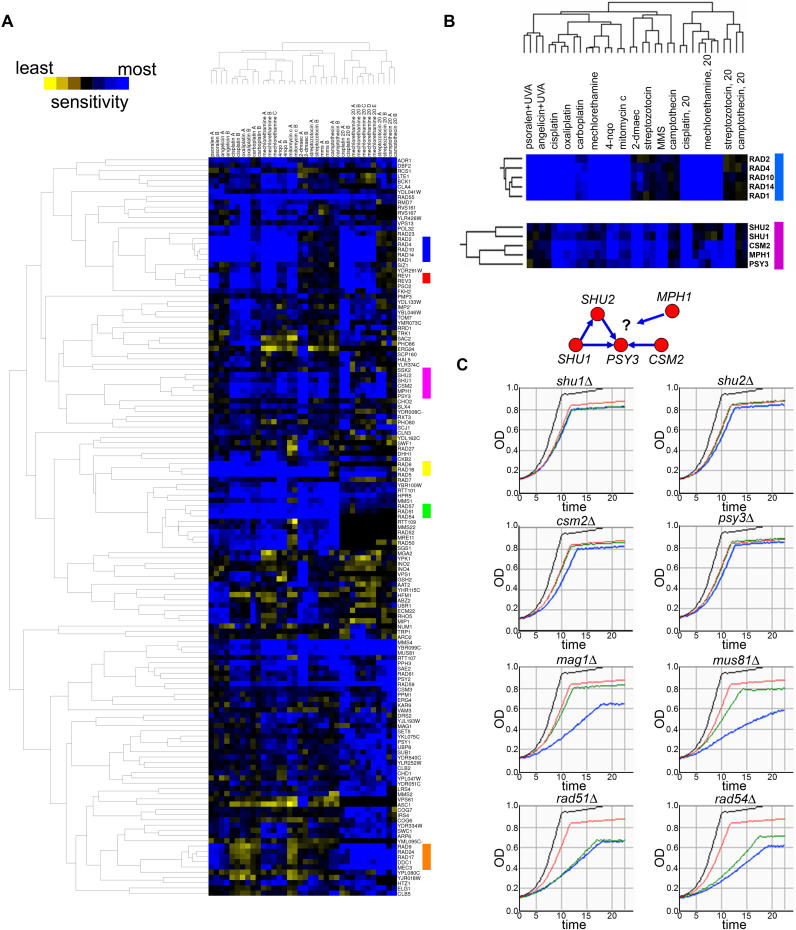
Hierarchical Clustering of Genome-Wide Profiles Identifies Mechanistic Relationships Between Drugs and Functional Relationships Between Genes(A) Clustergram containing all strains significant in two or more array experiments. Raw fitness-defect values were hierarchically clustered using Spearman's rank correlation. Colored bars represent gene clusters of note, including NER (RAD2, RAD4, RAD10, RAD14, and RAD1—blue); error-prone TLS (REV1 and REV3—red); PRR (RAD6, RAD18, and RAD5—yellow); homologous recombination (RAD57, RAD51, and RAD54—green); cell-cycle checkpoint control (RAD9, RAD24, RAD17, DDC1, and MEC3—orange); and a cluster shown in (B) (SHU2, SHU1, CSM2, MPH1, and PSY3—magenta).(B) Zoom view showing one cluster containing the class I NER genes and a second cluster containing several uncharacterized DNA-repair genes. Four of these five genes (SHU1, SHU2, CSM2, and PSY3) are known to encode proteins that physically interact [65,77,78].(C) Individual growth curves of single and double deletion strains with MPH1 in 0.002% MMS. In all panels, the growth of wild-type (BY4741) is represented by the black curve and the growth of mph1Δ by the red curve. The growth of eight different deletion strains (shu1Δ, shu2Δ, csm2Δ, psy3Δ, mag1Δ, mus81Δ, rad51Δ, and rad54Δ) are shown in green, and double mutants, in which the MPH1 deletion is added to each of the above, are shown in blue. Double mutants of MPH1, MAG1, and MUS81 show additive or synergistic sensitivity to MMS, whereas double mutants of MPH1, with the four other genes in its cluster, show no additional sensitivity to MMS, suggesting that MPH1 is epistatic with SHU1, SHU2, CSM2, and PSY3.